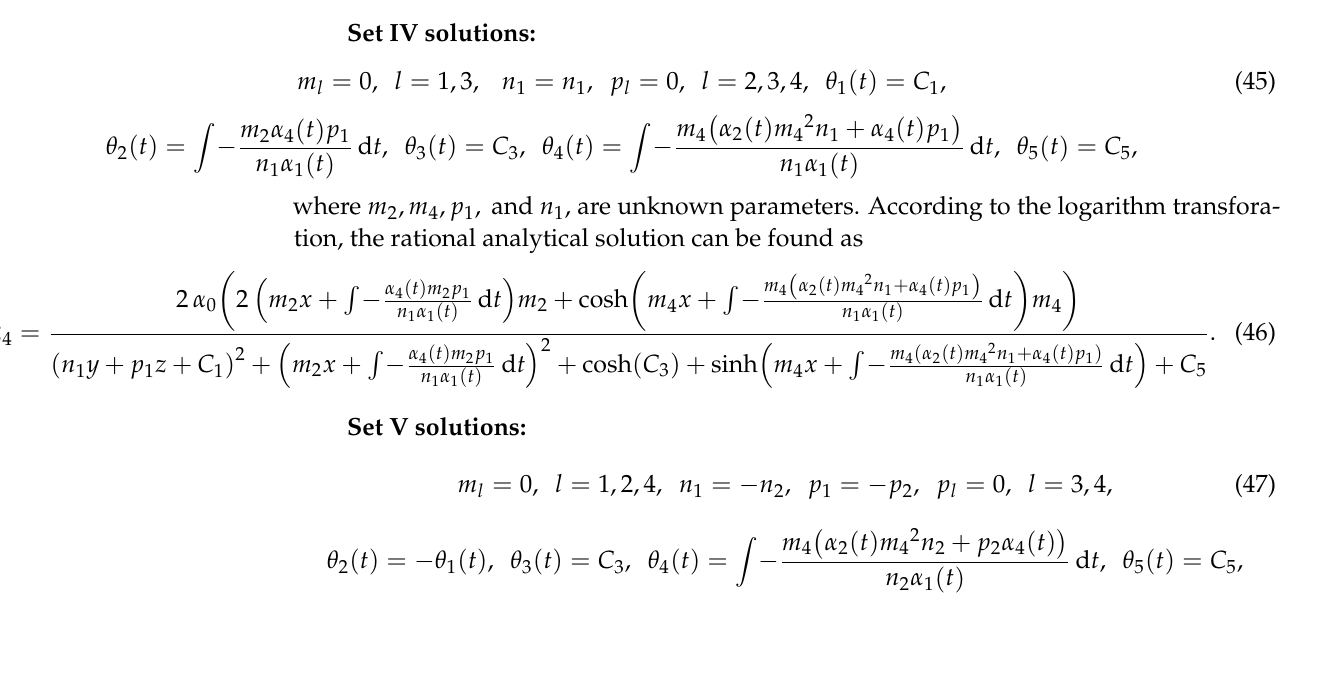
Figure 4. Plot of lump two-soliton solution (43) ( Γ 1 ) such as density plot for three spaces x = − 2,0,2, respectively, sub figures ( f1 ) for x = − 2, sub figures ( f2 ) for x = 0, and sub figures ( f3 ) for x =